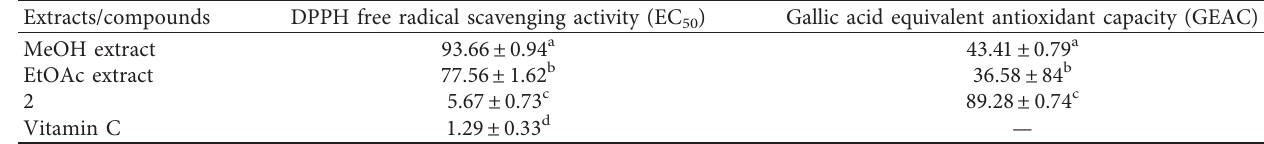
EC 50 : equivalent concentrations of test samples scavenging 50% of DPPH radical. Data represent the mean ± SD of three independent experiments carried out in triplicate. In the same column, values earmarked by different superscript letters (a–d) are significantly different according to one-way ANOVA and Waller- Duncan test; p < 0 .